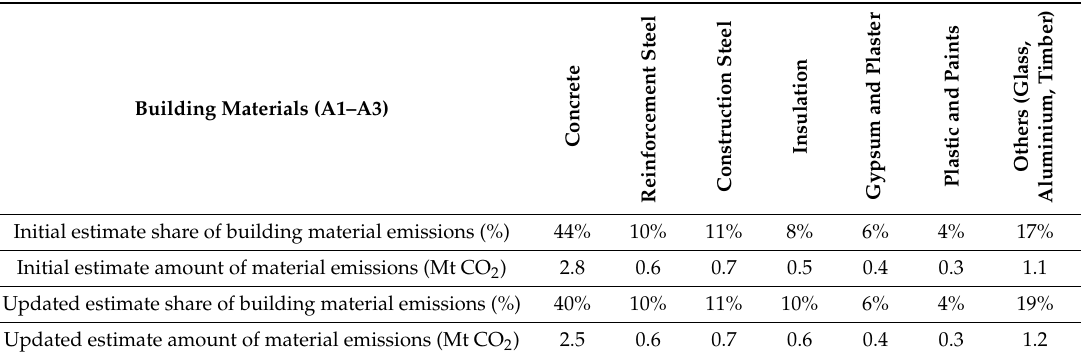
Table 4. Initial and updated annual emissions estimates per material for building construction in the base year of 2015. The initial estimates are based on a combination of emissions share data per lifecycle stage for construction of new buildings together with data on construction of di ff erent building / frame types, while the updated estimates are the data used in the model after adjustments for refurbishments and